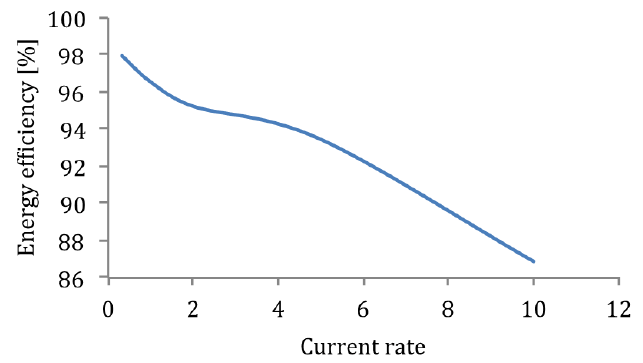
Figure 30. Energy efficiency versus current